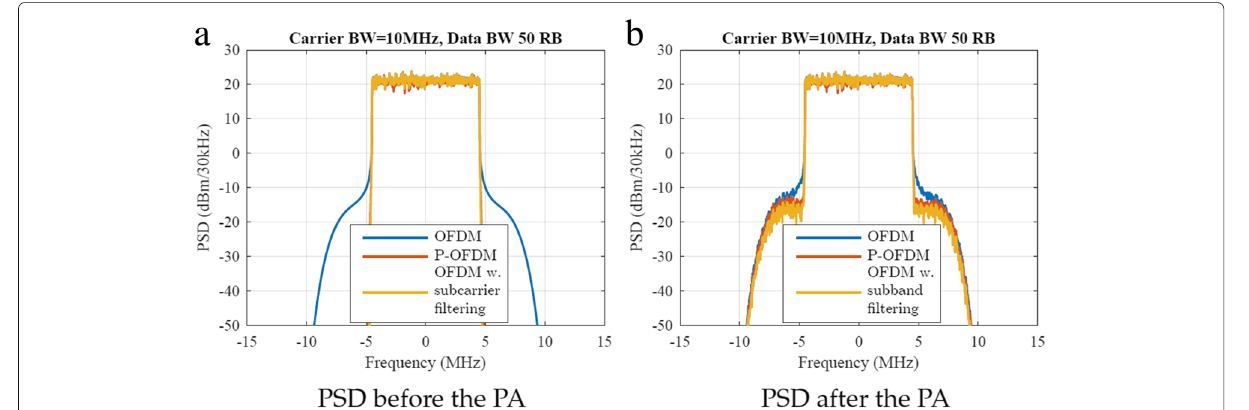
Fig. 16 a , b PSD of different waveforms before and after the non-linear power amplifier